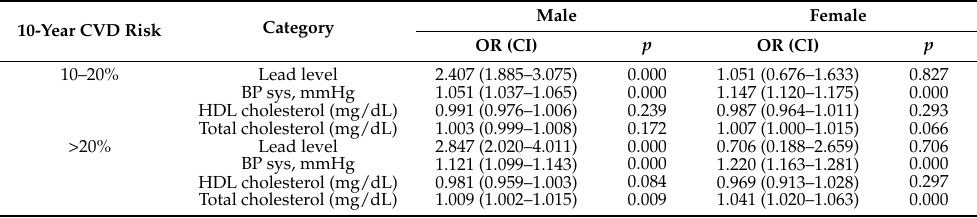
Table 3. Odds ratio for FRS among the sub items (Sys BP, HDL, Total Cholesterol) and Lead